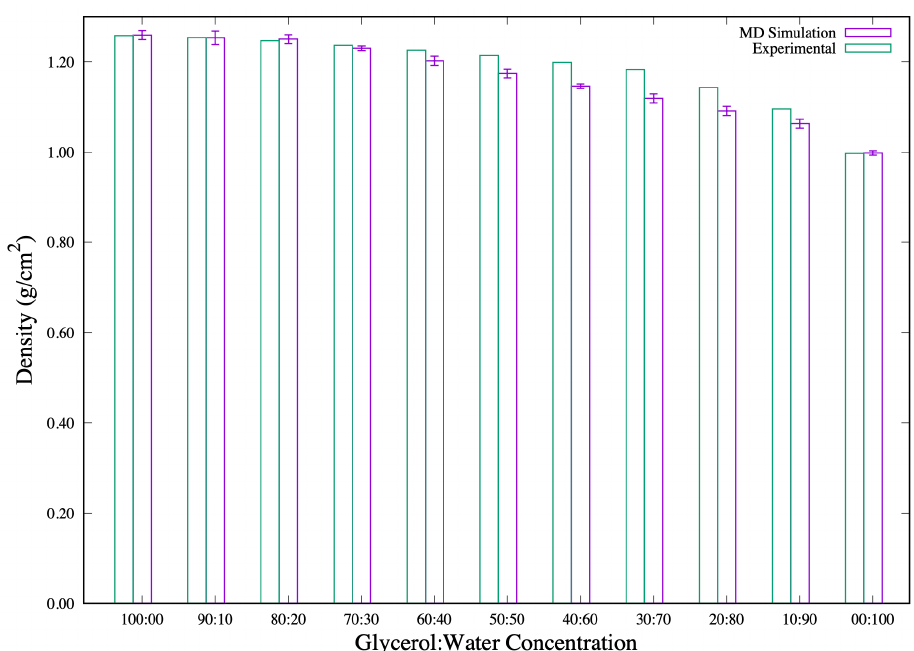
Figure 1. Densities, ρ (g/cm 3 ) of glycerol and glycerol-water ( x 1 : x 2 ) mixtures at 298.15K and atmospheric